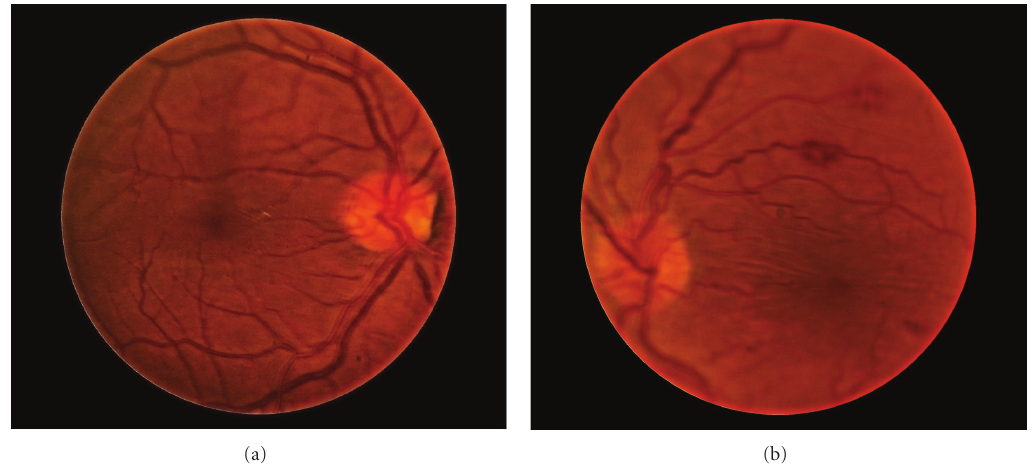
Figure 1: (a) Right eye: normal. (b) Left eye: di ff use intraretinal hemorrhages, some white-centered, with macular striae.